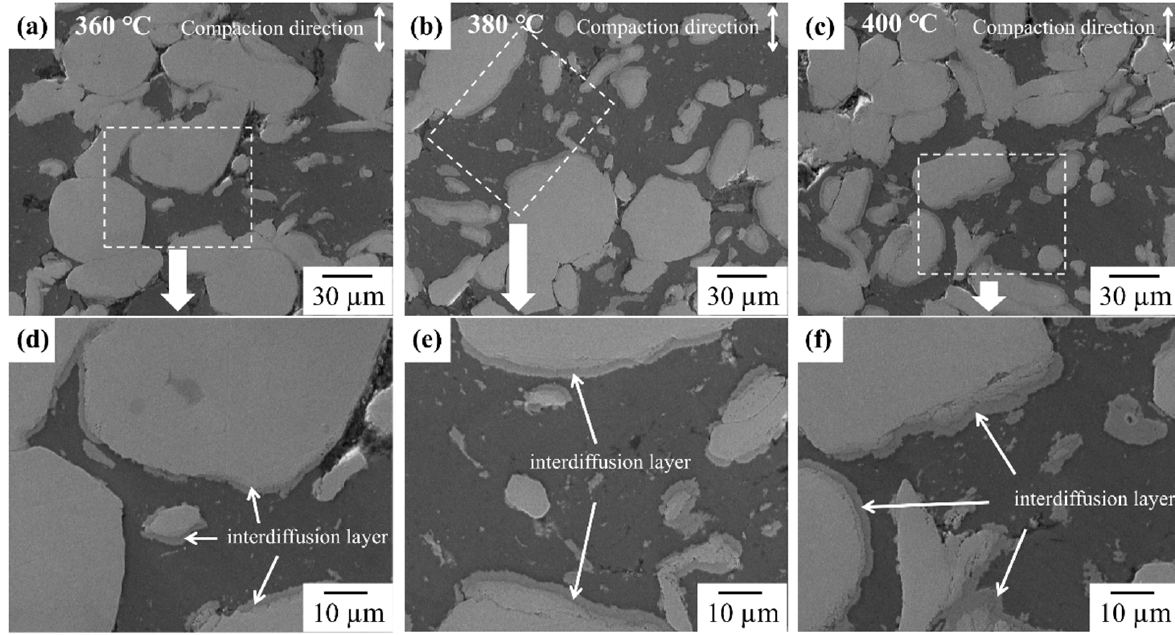
Figure 3. FE ‐ SEM image of Al ‐ 50vol%Cu sintered at ( a , d ) 360 °C, ( b , e ) 380 °C, and ( c , f ) 400 °C. Figure 3. FE-SEM image of Al-50vol%Cu sintered at ( a , d ) 360 ◦ C, ( b , e ) 380 ◦ C, and ( c , f ) 400 ◦ C. The Al/Cu interfaces in the Al–Cu composites sintered at 360, 380, and 400 ◦ C were analysed using FE-SEM and EDS line scans, and the results are shown in Figure 4. The bright and the dark regions in the FE-SEM images in Figure 4a–c are the Cu and Al sides, respectively. EDS line scanning was conducted from the Cu side to the Al side through the Al/Cu interface without pores and cracks. As shown in Figure 4d–f, the EDS scan